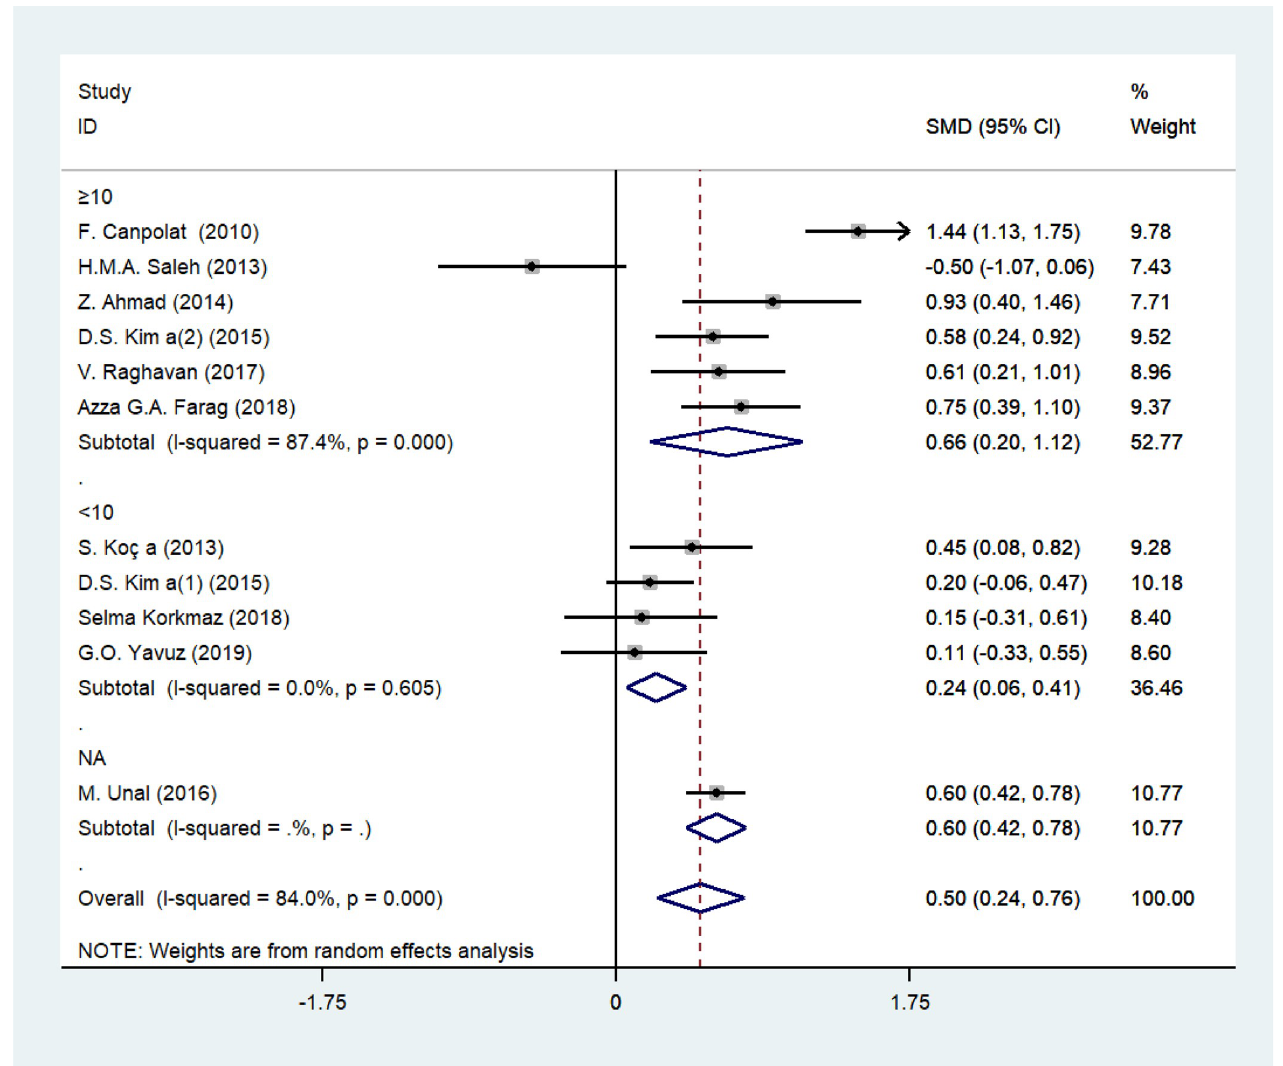
Fig 5. Stratified analyses of disease severity assessed by PASI for the association between MPV and psoriasis.